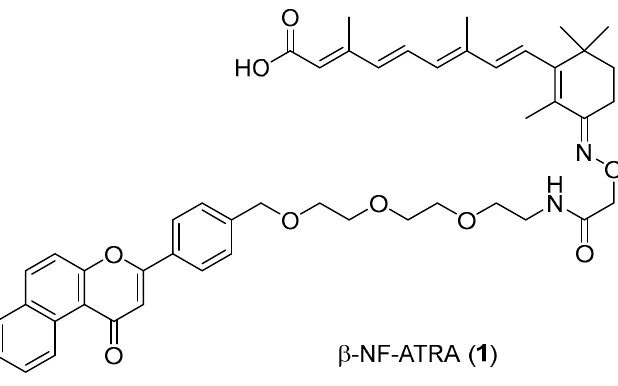
Figure 1. Chemical structure of β -NF-ATRA ( 1 ).